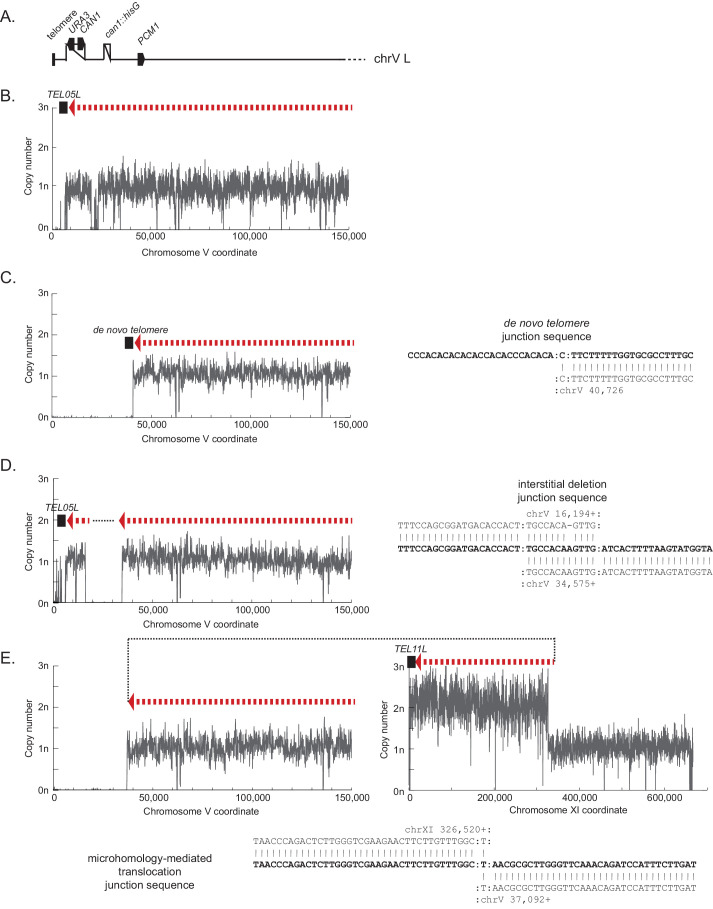
Example copy number plots for simple GCR structures not involving foldback inversions.The example copy number plots for the foldback inversion GCRs are displayed in Figure 1D and Figure 1E. The regions included in the GCR-containing chromosome are displayed using the red dashed arrow (oriented from chrV R to chrV L in the GCR-containing chromosome). The black dotted lines show the connectivity between regions included in the GCR-containing chromosome that are separate in the reference genome. Telomeres added to the chrV L side of the GCR are displayed using black boxes. (A) The diagram of the uGCR chrV L assay is drawn to scale for the copy number plots below. (B) The copy number plot (read depth at each base in the uniquely mapping regions of the genome divided by the median read depth of the nuclear chromosomes) for chrV L in a parental strain that has not formed a GCR. (C) The copy number plot of an example of a de novo telomere addition GCR (PGSP2215, isolated from a pif1Δ strain). (D) The copy number plot of an example of an interstitial deletion (PGSP5065, isolated from an exo1Δ yku80Δ strain). (E) The copy number plot of an example of a microhomology-mediated translocation with chrV L on left and the duplicated target (in this case chrXI) on the right (PGSP940, isolated from a sgs1Δ strain). Note that the duplication of the region of chrXI L indicates that the translocation-containing GCR is present in addition to an intact chrXI.